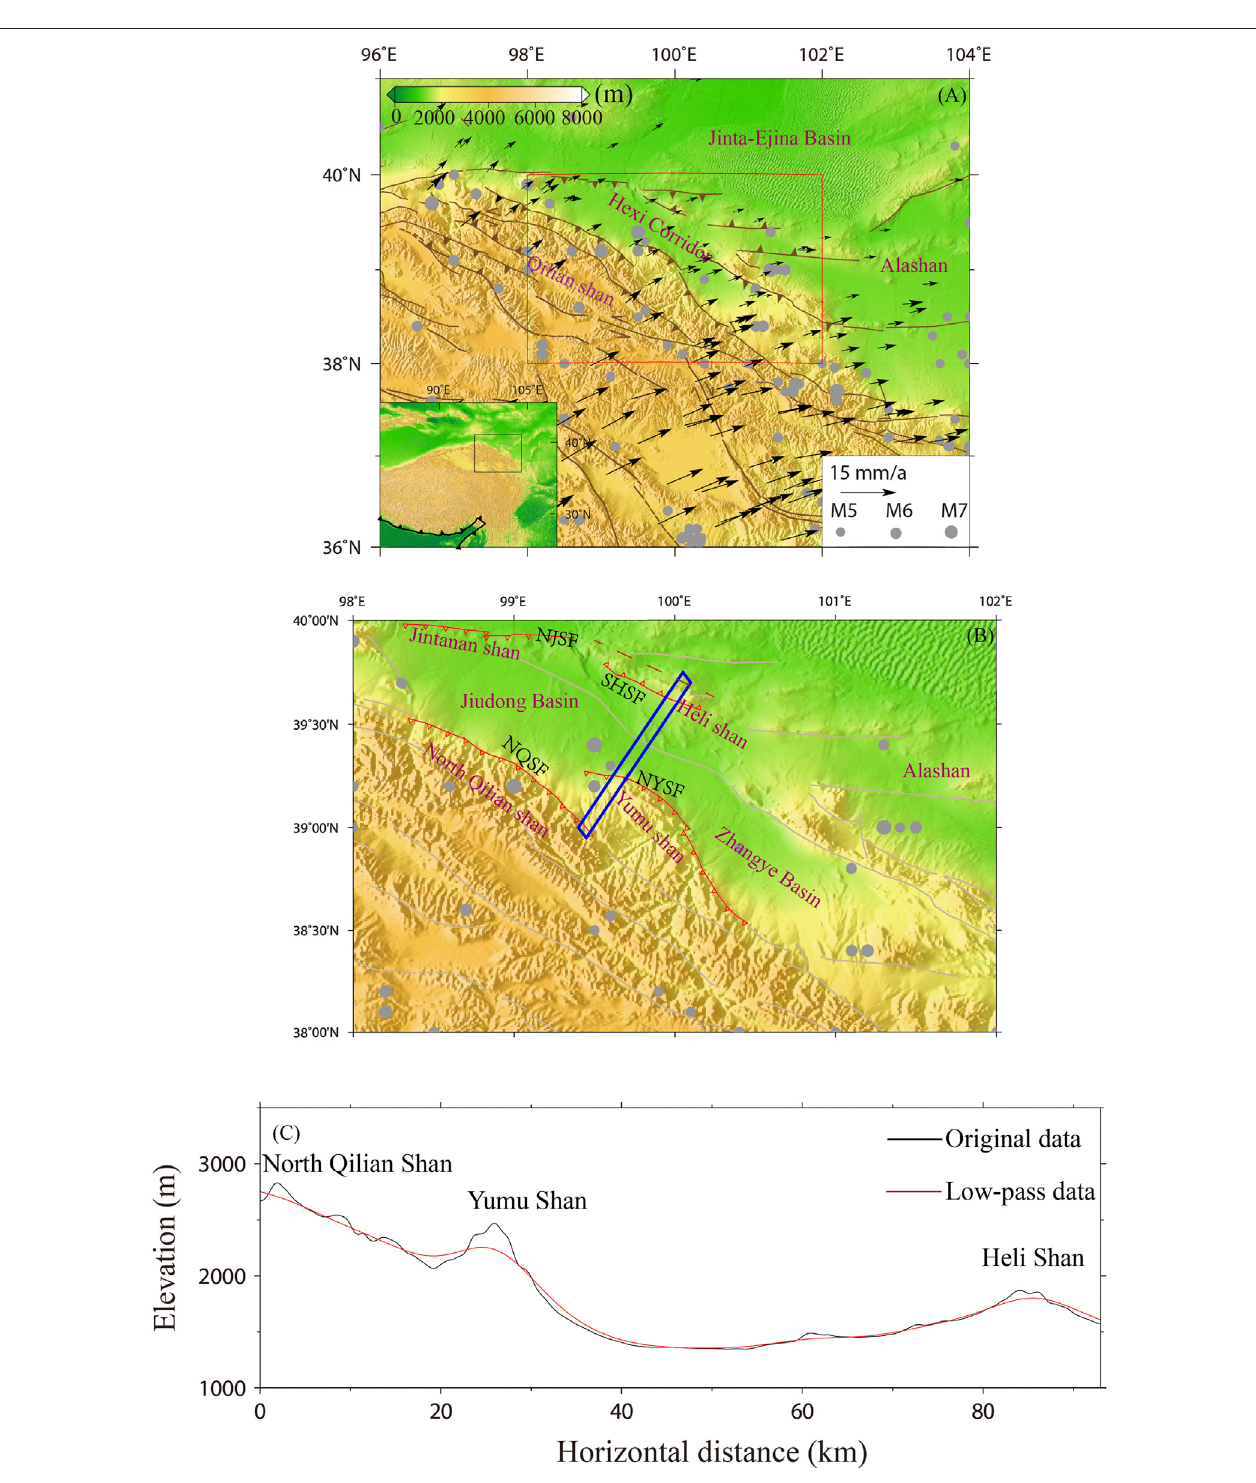
FIGURE 1 | Tectonic setting of Jiudong Basin in northern margin of Qinghai – Tibetan Plateau. (A) GPS velocities (Wang and Shen, 2020), historical earthquakes (780 B.C. – A.D. 2019, M > 5.0) (*), and topography (in meters above sea level) of Jiudong Basin (Zhang et al., 2017; Hu et al., 2019; Wang et al., 2020) and surrounding regions. Locations of major faults are from Yuan et al. (2013). (B) Enlarged subset of red rectangle in (A) . Four main thrusts, i.e., NQSF: North Qilian-Shan Fault, NYSF: NorthYumu-ShanFault,SHSF:SouthHeli-ShanFault,andNJSF:NorthJintanan-ShanFault. (C) Elevationinmetersabovesealevel(m.a.s.l.)pro fi lealongblueline section in (B) , with original and low-pass versions of data. Three main mountain ranges in Jiudong Basin are visible: North Qilian Shan, Yumu Shan, and Heli Shan. (*) Department of Earthquake Disaster Prevention, State Seismological Bureau, 1995; Department of Earthquake Disaster Prevention, China Earthquake Administration, 1999.